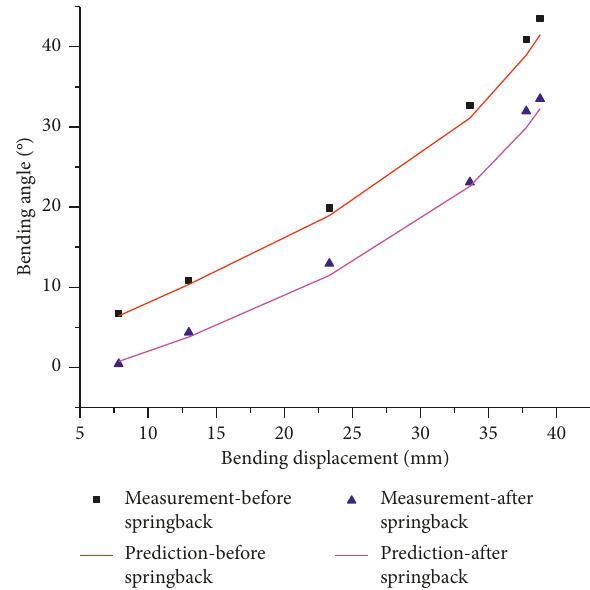
Figure 13: Verification with the bending angle.